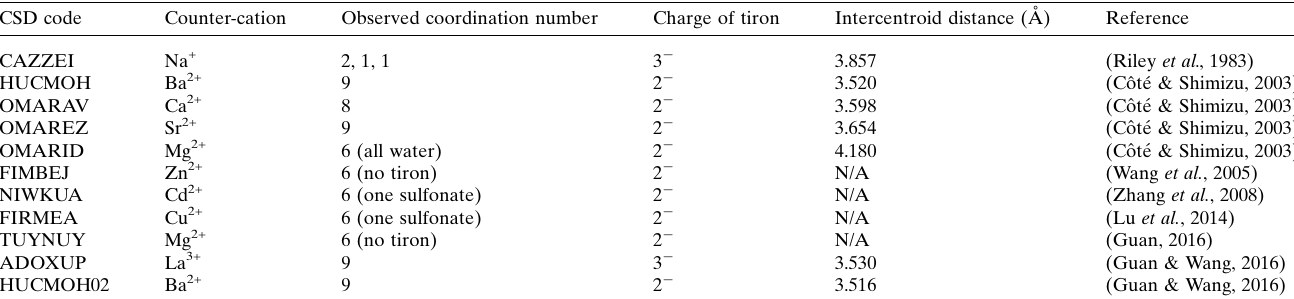
Table 5 Crystallographically characterized tiron